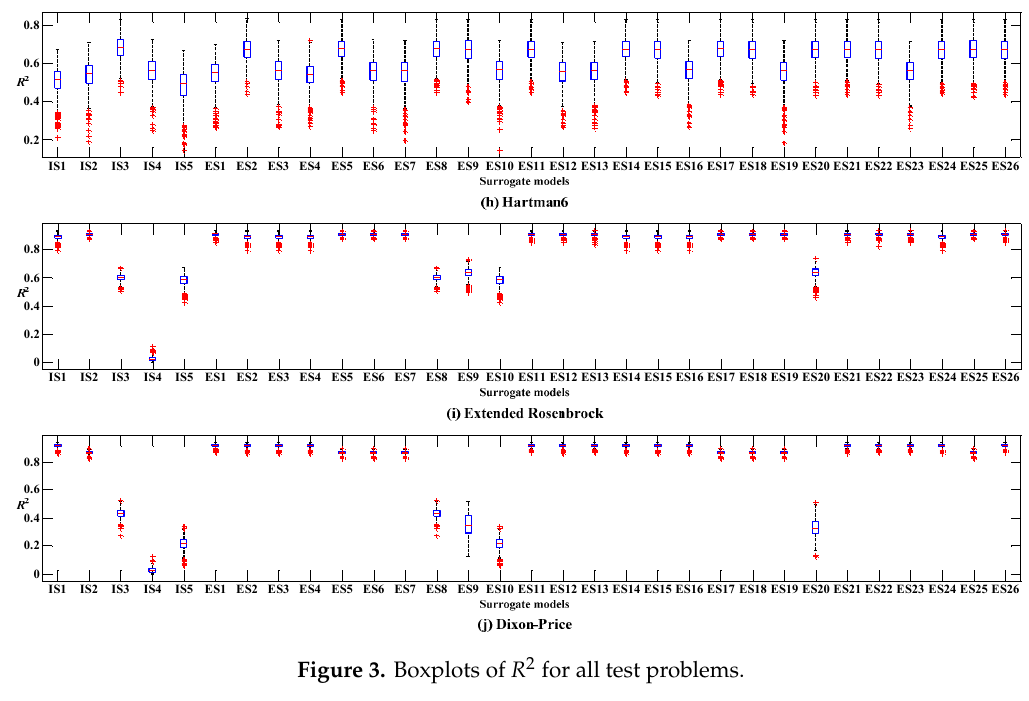
Figure 3. Boxplots of R 2 for all test problems.